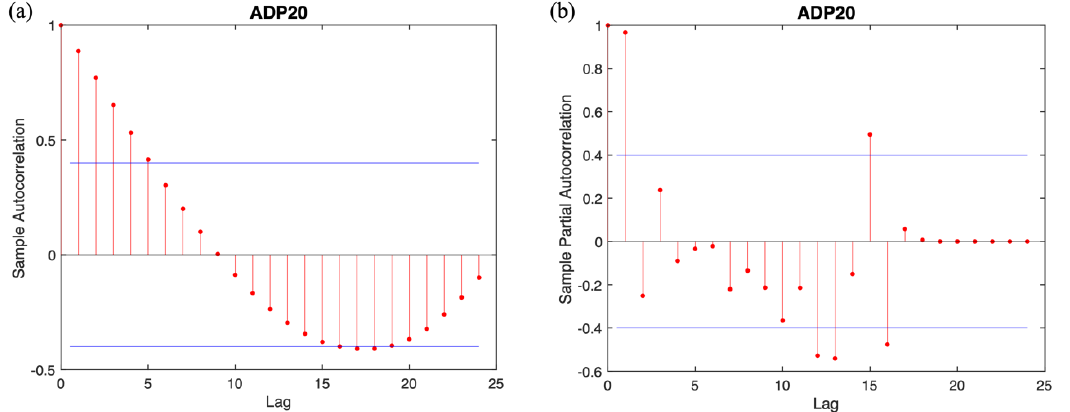
Figure 1. The ACF ( a ) and PACF ( b ) of sample ADP20 biogas production time series from day 4. The blue lines are the confidence bounds for a significant correlation. The red lines are the autocorrelation and partial autocorrelation between the current time step and the time steps of different lags.